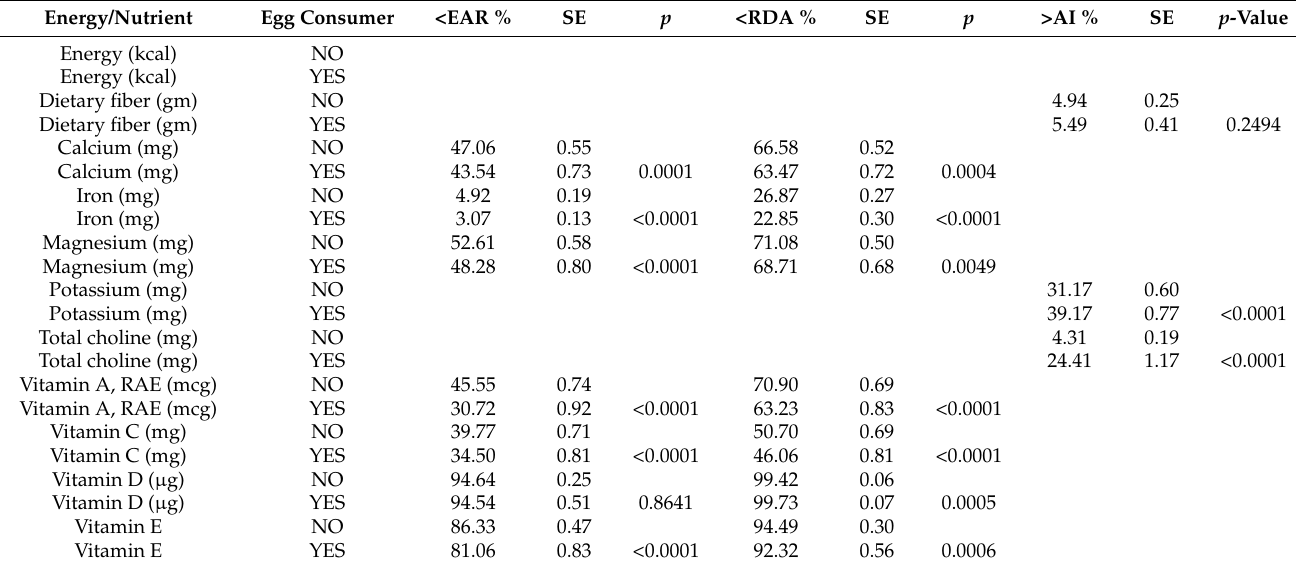
Table 2. Percent of U.S. individuals below the EAR and above the AI in egg consumers vs. egg non-consumers.